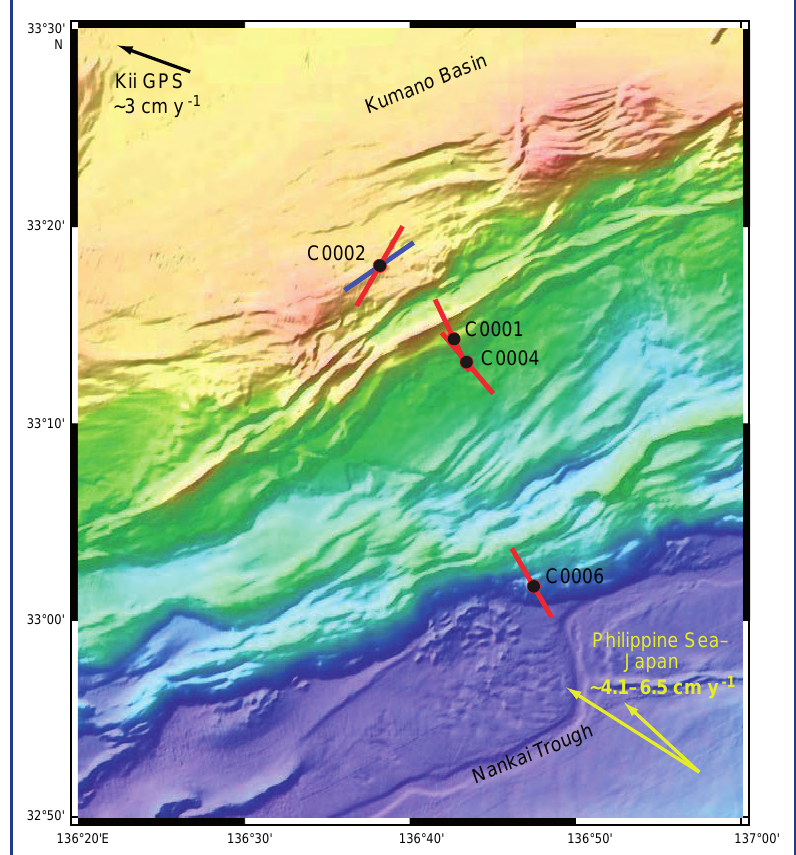
Figure 10. Azimuth of maximum horizontal stress estimated from borehole breakout images at Sites C0001, C0002 (in basin above 936 mbsf), C0004, and C0006 (red lines). Blue line = estimate for older accretionary prism formation below 936 mbsf at Site